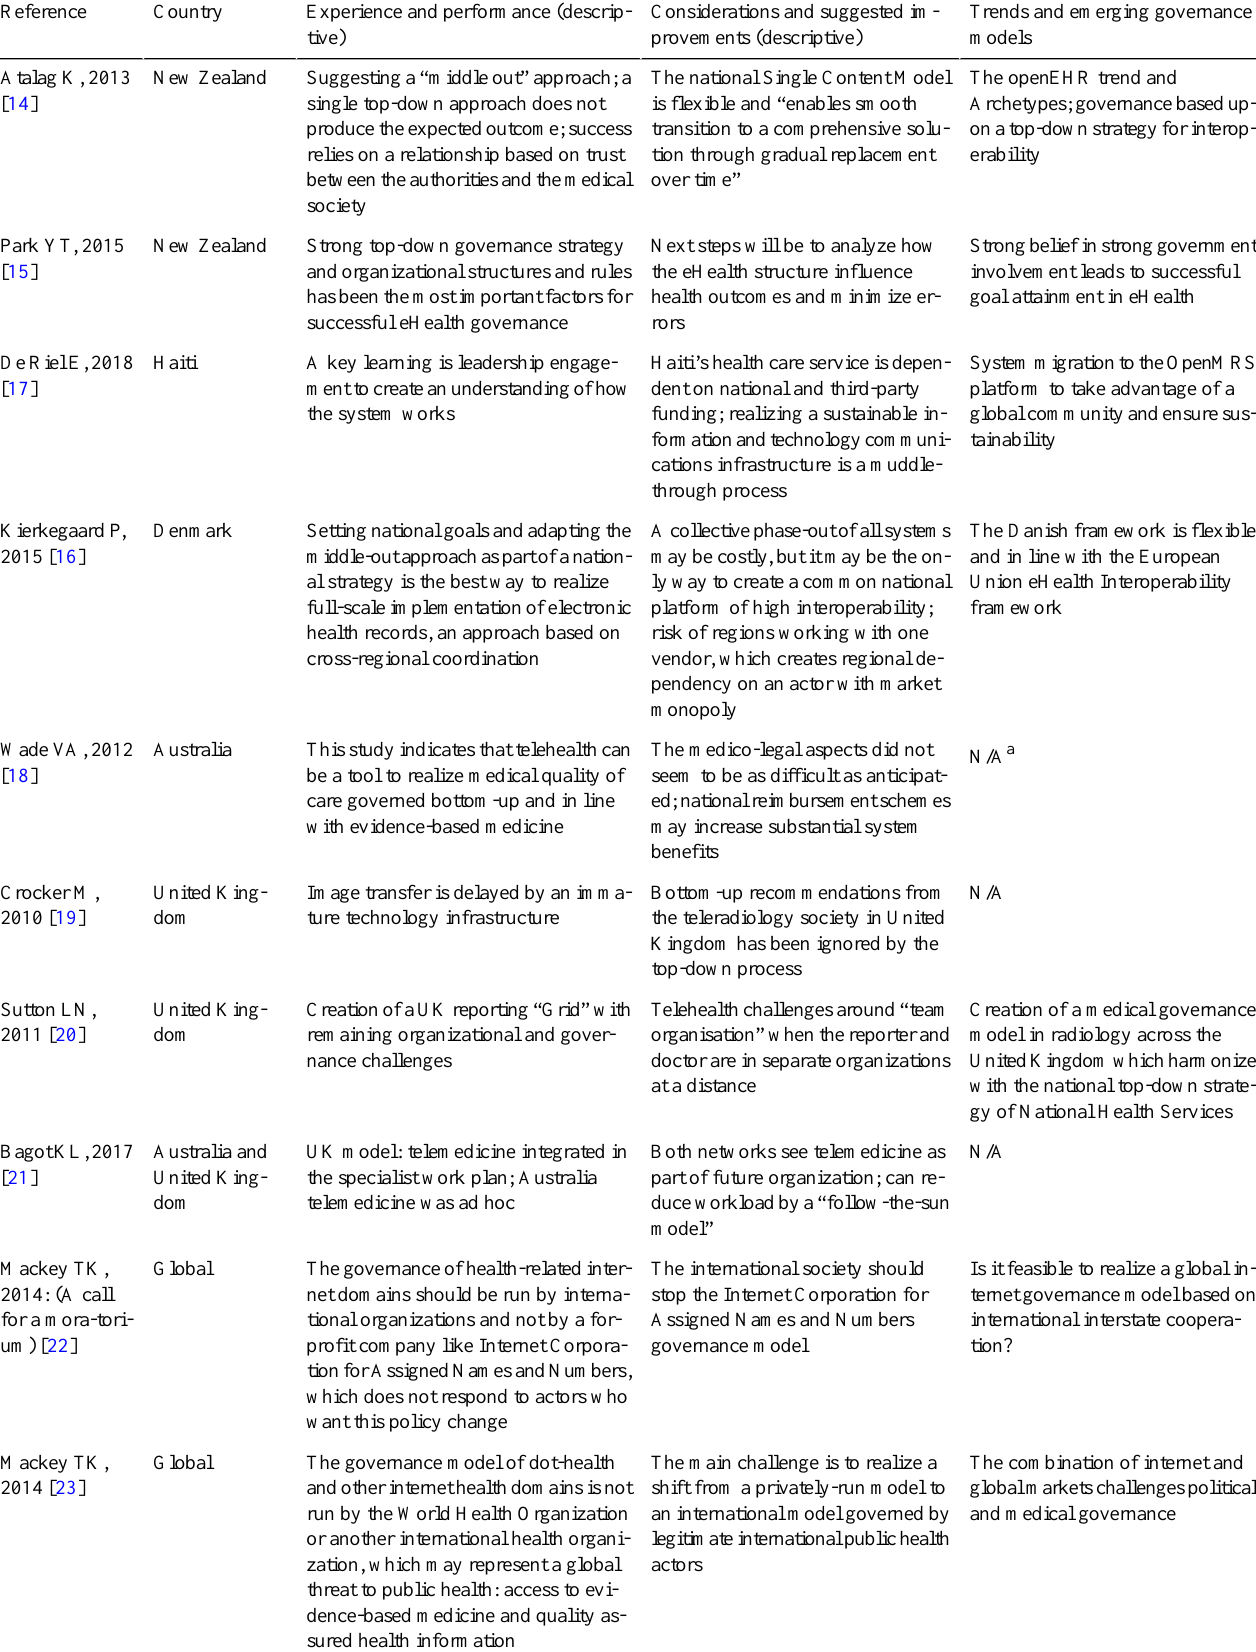
Table 2. Included papers, considerations, and emerging governance